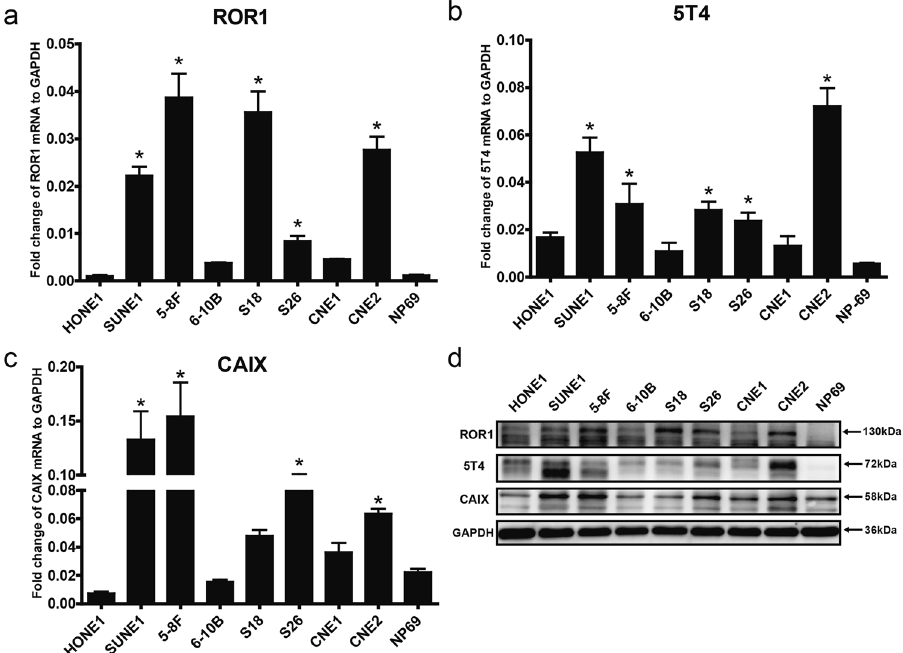
Figure 1. Expression of ROR1, 5T4 and CAIX in NPC cell lines. The mRNA expression levels of ROR1 ( a ) 5T4 ( b ) and CAIX ( c ) in eight NPC cell lines and the normal nasopharyngeal epithelial cell line NP69 were measured using RT-qPCR and normalized to GAPDH. Values are shown as the mean ± SD of triplicate samples. * indicates p < 0.05 (one-way ANOVA) in comparison with NP69 cells. ( d ) The protein expression of ROR1, 5T4 and CAIX in the same nine cell lines was probed using WB with specific antibodies. GAPDH was used as a loading control. The molecular weight of each protein is marked on the right. The results shown are representative of three independent